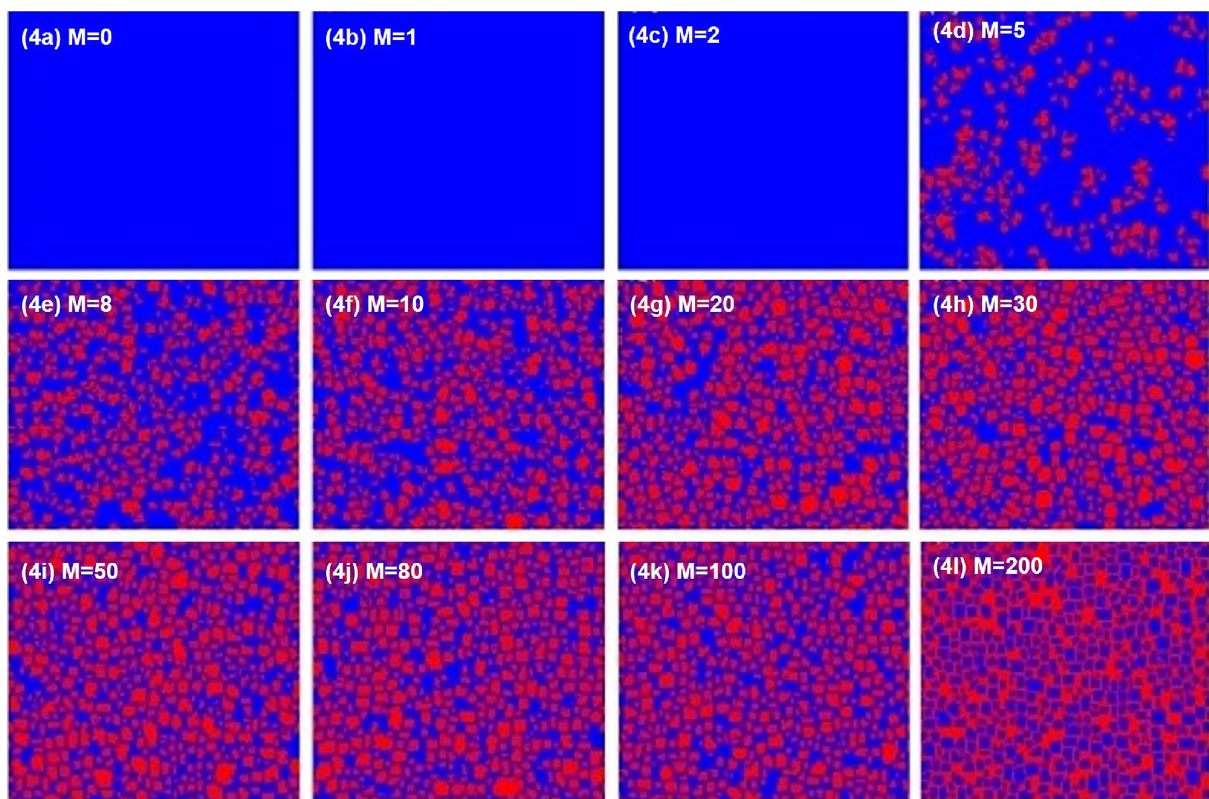
Figure 4. When T = 1.05 and K = 0.1 , the characteristic pattern of steady state under different M ( M = 0, 1, 2, 5, 8, 10, 20, 30, 50, 80, 100, 200 ).